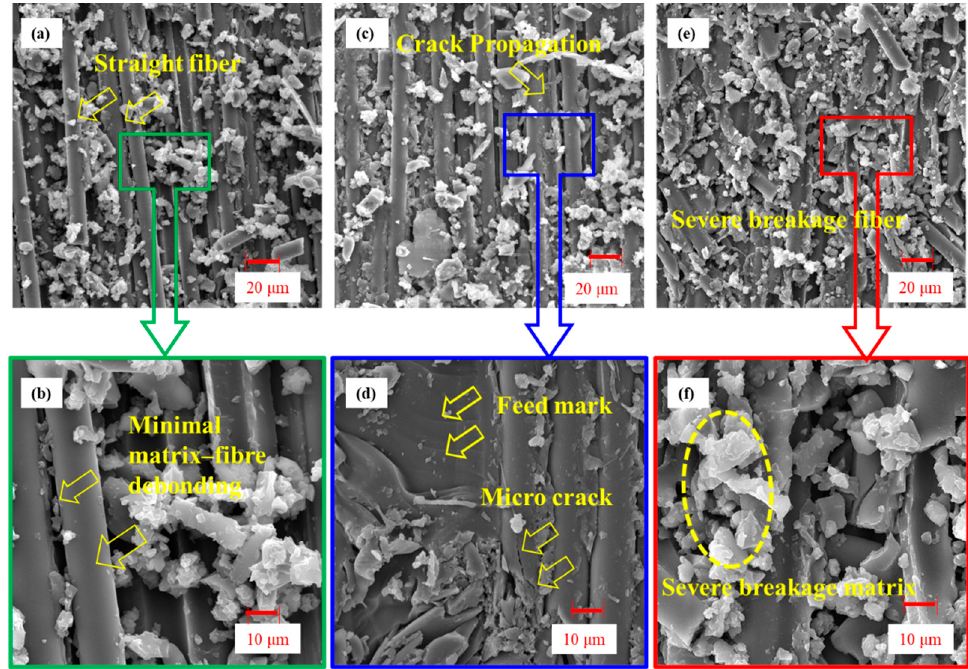
Figure 10. Spectroscopy analysis (SEM) of milling workpiece for ( a ) 1 wt.% GO at 20 μ m, ( b ) 1 wt.% GO at 10 μ m, ( c ) 2 wt.% GO at 20 μ m, ( d ) 2 wt.% GO at 10 μ m, ( e ) 3 wt.% GO at 20 μ m, and ( f ) 3 wt.% GO at 10 μ m . Table 3. Comparative analysis with the previous result. Sr.